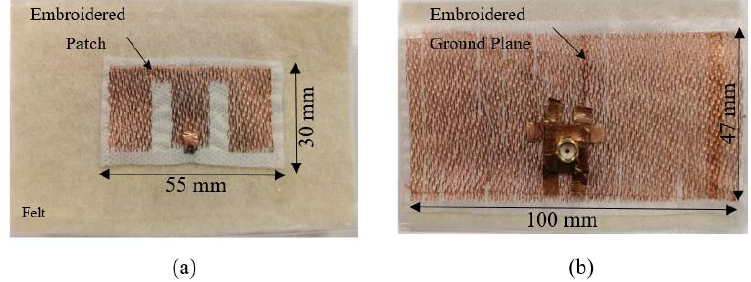
Figure 2. E-shape antenna fabricated based on embroidering technique ( a ) top view; ( b ); bottom view.